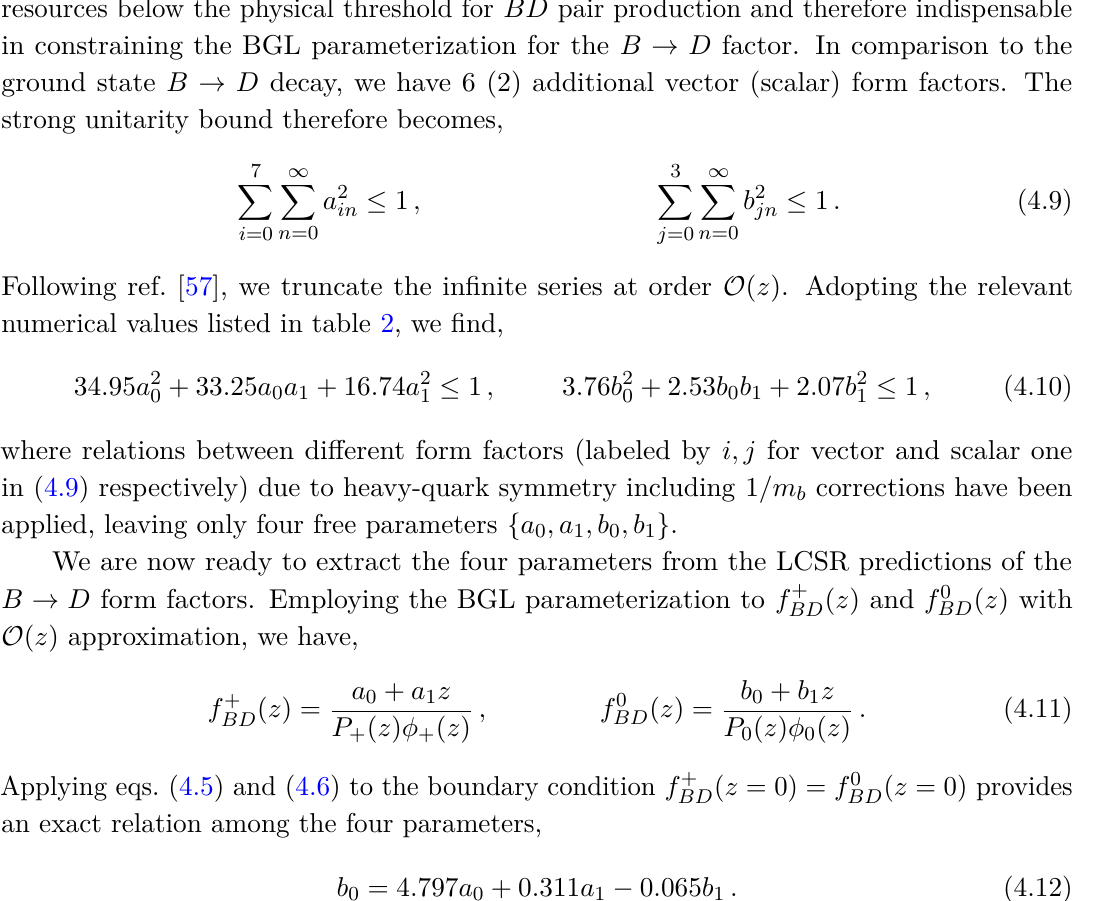
factors describing the B ( ∗ ) D ( ∗ ) states 6 [104, 112]. These form factors are generated by B